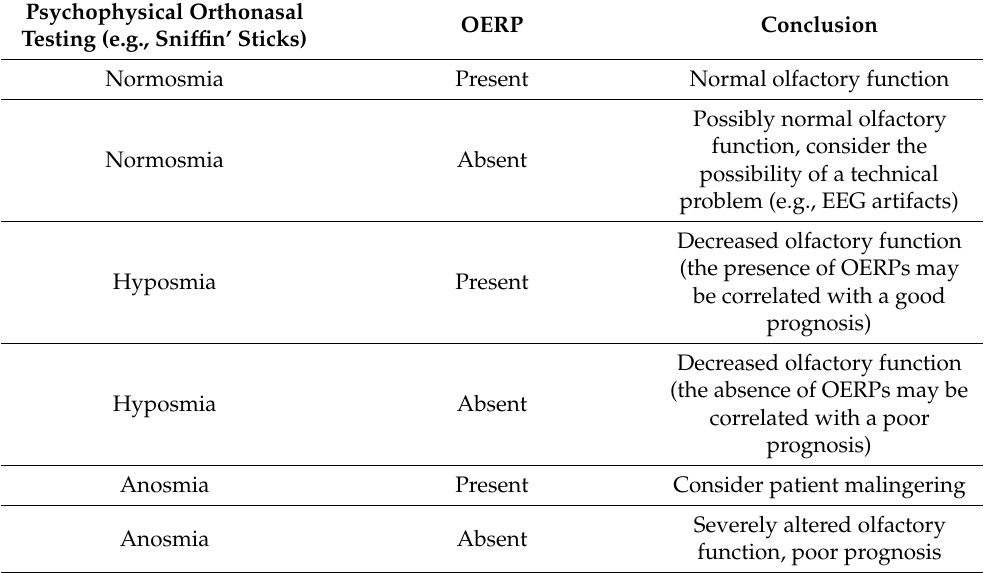
Table 1. Clinical assessment of olfactory function when combining the psychophysical and elec- trophysiological testing (OERPs) [50]. Copyright © 2007 The Triological Society Andrè Mouraux, Thomas Keller, Bernard Bertrand, et al., Clinical Significance of Olfactory Event-Related Potentials Related to Orthonasal and Retronasal Olfactory Testing, The Laryngoscope.